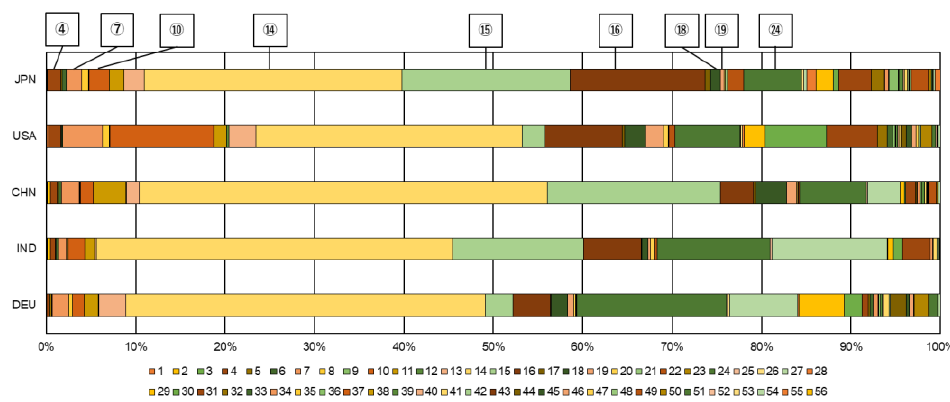
Figure 7. CO 2 emissions by sectors comprising construction EGs.